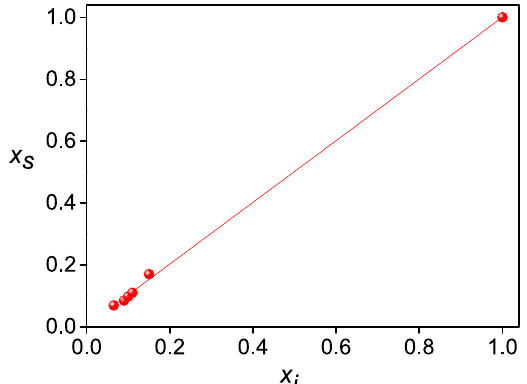
Figure 1. Variation of the composition x s determined from EDAX with the initial composition x i